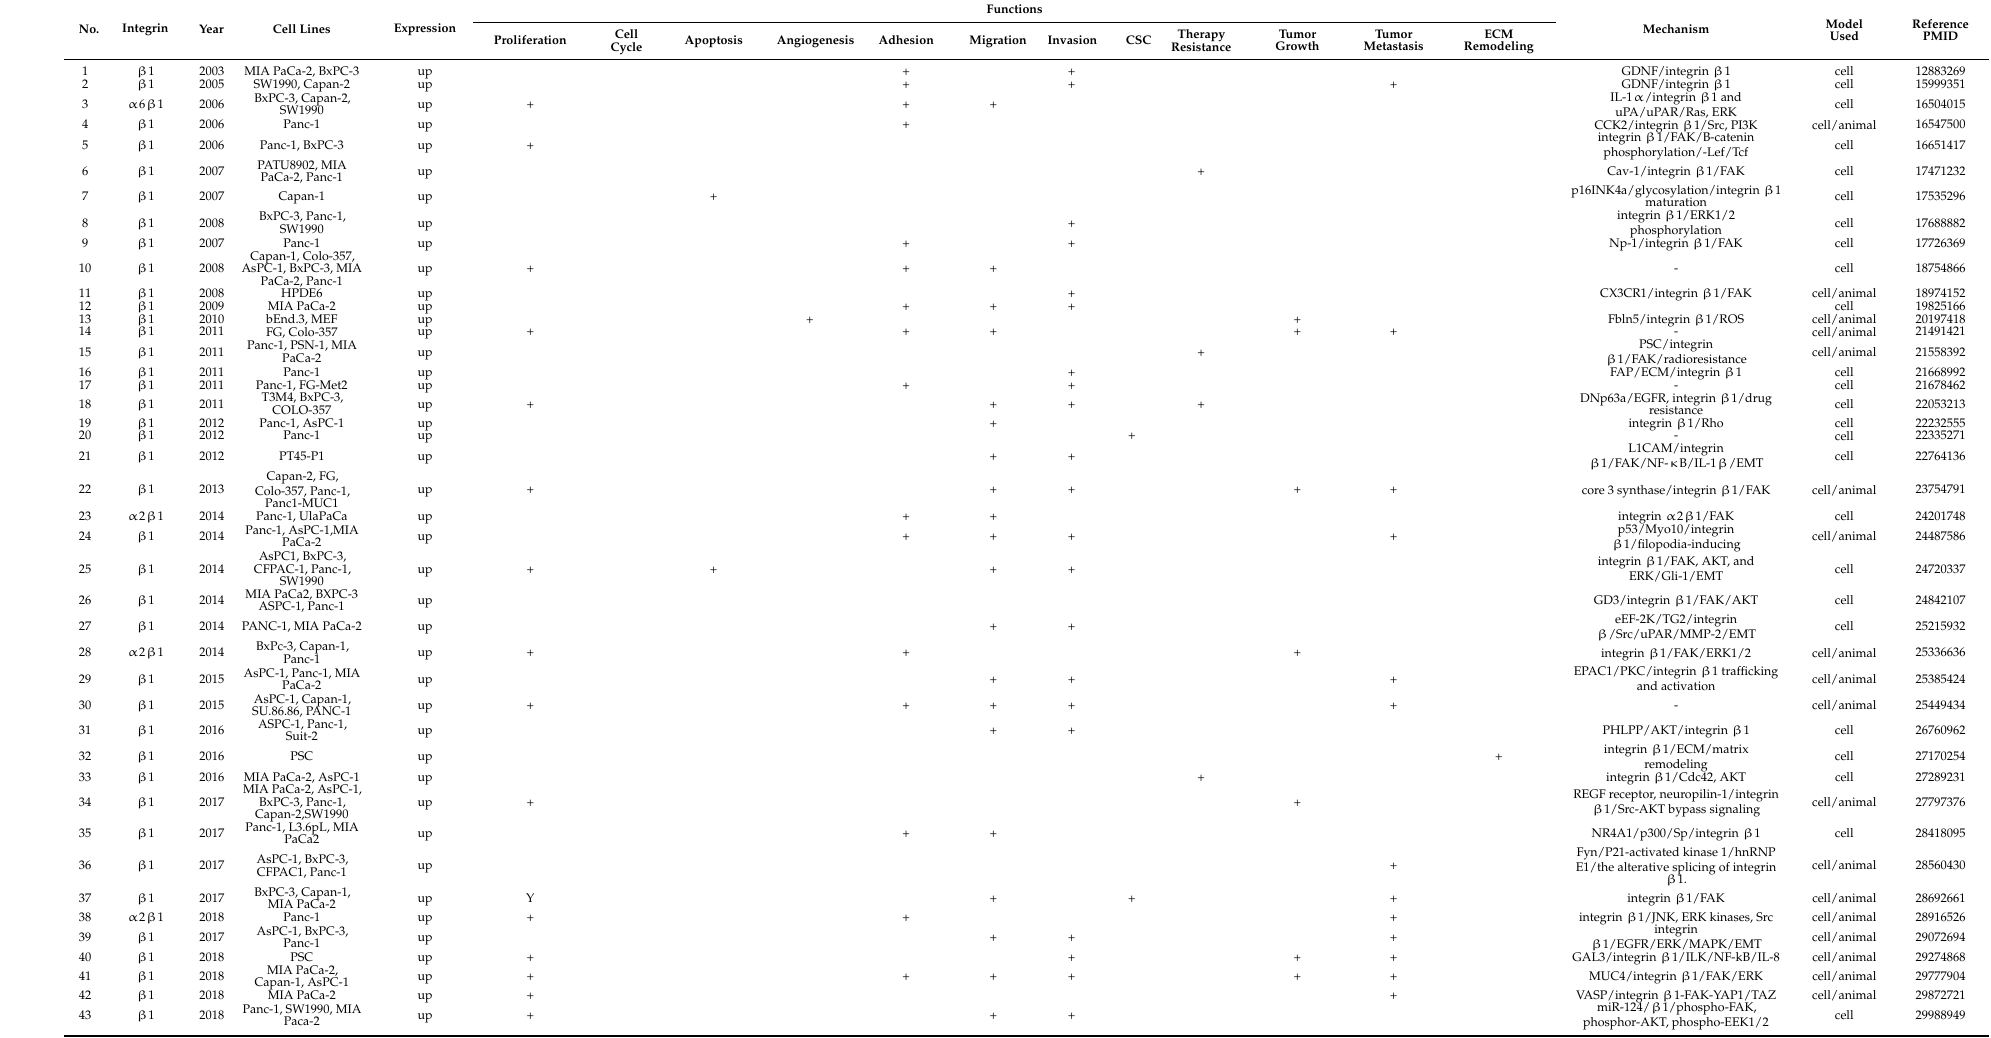
Table 1. Overview of cellular functions of reported β 1 integrins in pancreatic